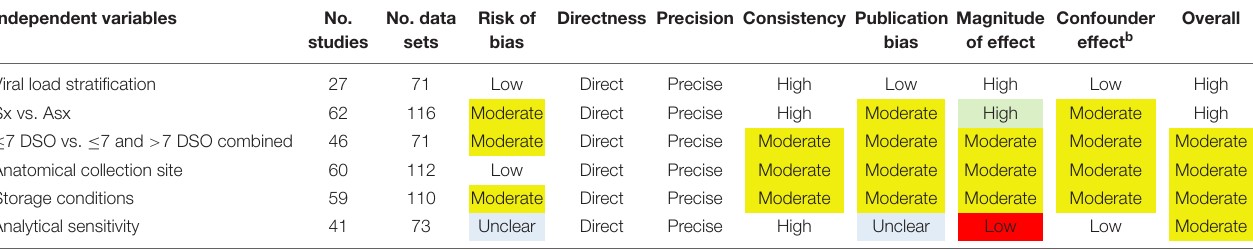
TABLE 2 | Overall quality of evidence for outcomes a (modified GRADE; Schunemann et al., 2013). Independent variables No.